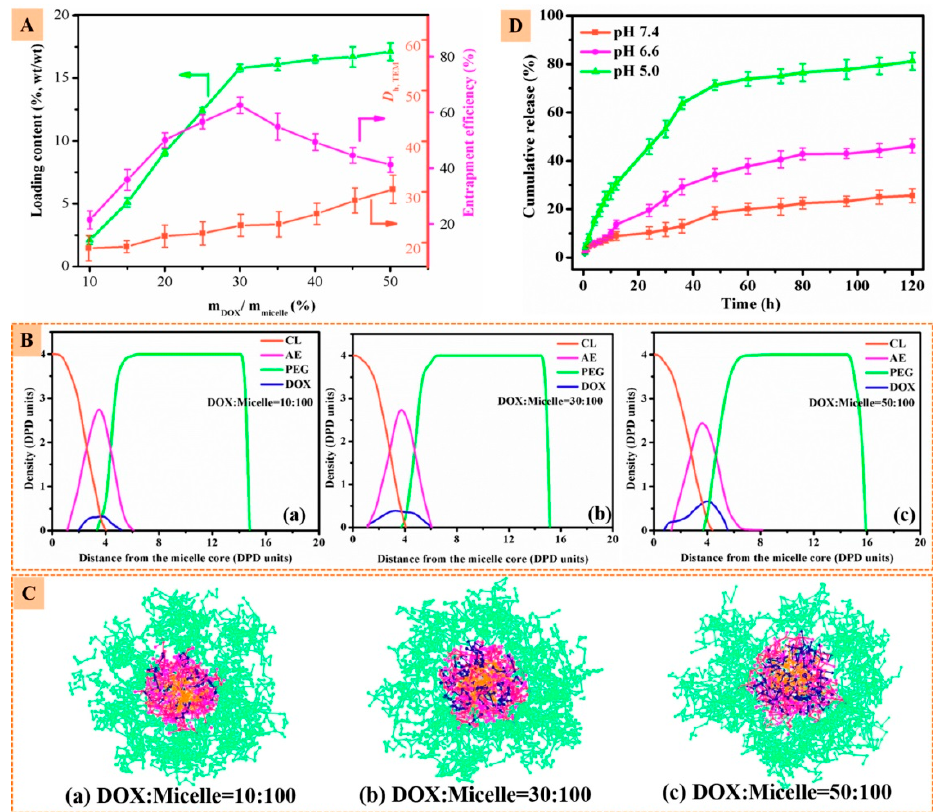
Figure 8. ( A ) Loading content, entrapment efficiency and sizes of β -CD-(PCL-PAEMA-PPEGMA)21/AuNPs/DOX as a function of m DOX /m micelle . ( B ) Density profiles of different beads and ( C ) cross-section views of β -CD-(PCL-PAEMA-PPEGMA)21/AuNPs/DOX micelles at different weight ratios. ( D ) In vitro drug release profiles of β -CD-(PCL-PAEMA-PPEGMA)21/AuNPs/DOX at different pH levels. Reprinted with permission from [139]. Copyright American Chemical Society, 2017.